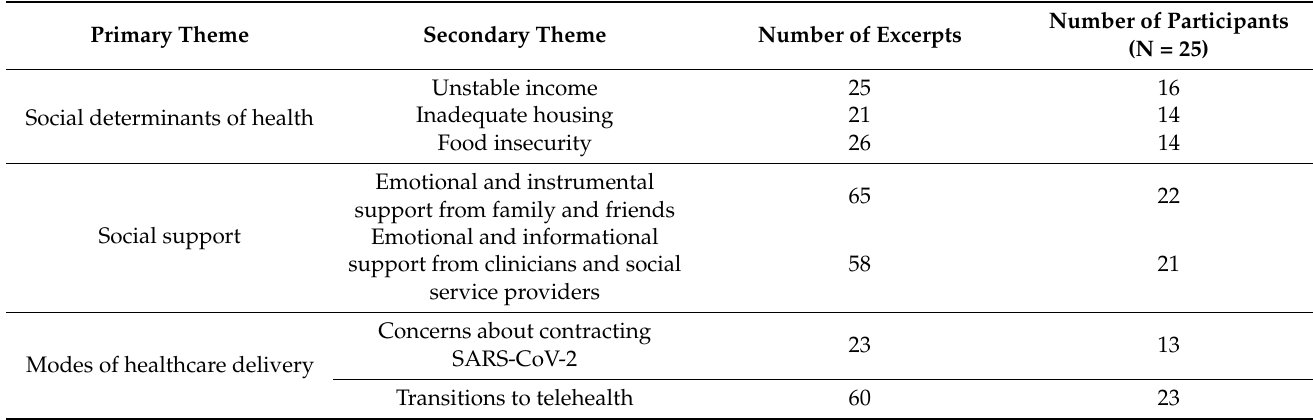
Table 2. Counts and Frequency of